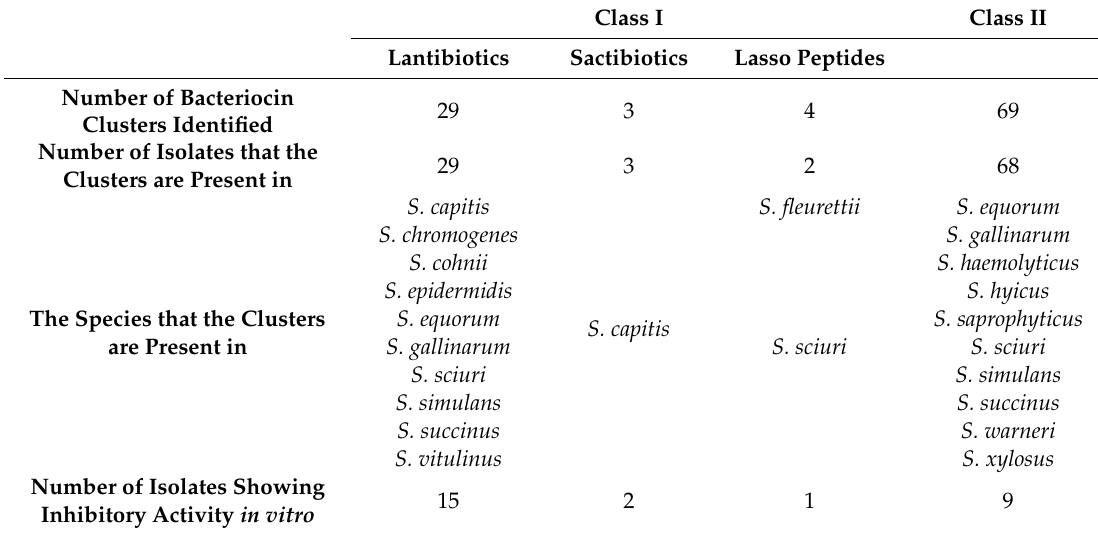
Table 2. Strains of Staphylococcus found to harbour bacteriocin gene-clusters from 441 non-aureus Staphylococcus isolates analysed, the number of isolates possessing bacteriocin production genes that displayed inhibitory activity, and the number of isolates displaying in vitro inhibitory activity against S. aureus strains isolated from bovine mastitis cases. Each cluster encodes one bacteriocin